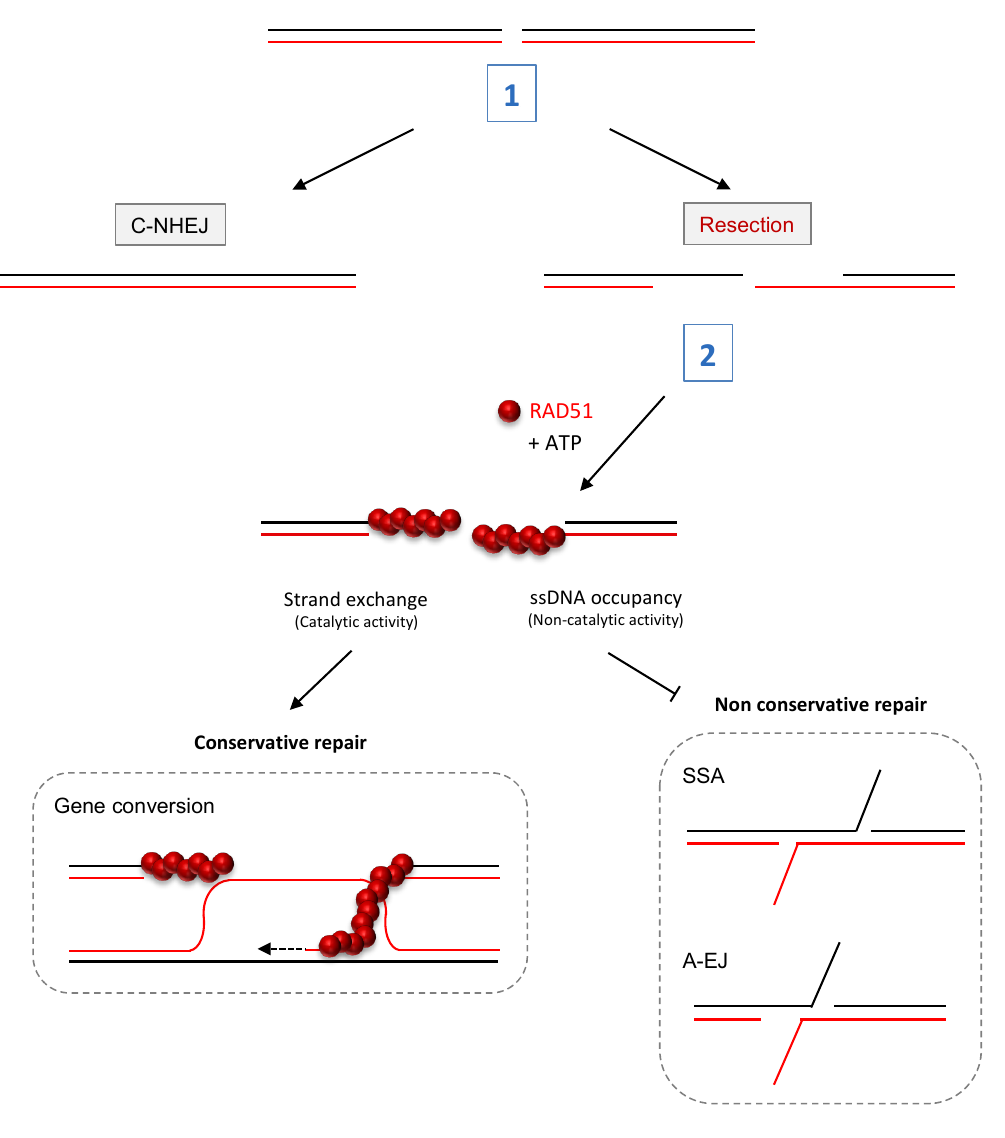
Figure 2. The selection of the DSB repair pathway in two steps. 1. Competition between end-joining of the DSB through the KU70/KU80/ligase 4-dependent NHEJ pathway, called canonical NHEJ (C-NHEJ), versus the resection of the DNA ends generating 3’-ssDNA tails. 2. On resected ssDNA, competition between conservative HR versus alternative nonconservative SSA or A-EJ. SSA and A-EJ occur upon the annealing of the two complementary ssDNA generated by the resection. SSA acts on long homologous sequences, whereas A-EJ acts on microhomologies (few bp). Since both processes anneal complementary sequences that can be distant from the DSB, they both ineluctably lead to the loss of the intervening sequence and are, thus, nonconservative. RAD51 (red dots) not only favors the gene conversion through its catalytic activity but also prevents SSA and A-EJ by occupying the ssDNA and impairing the annealing of the complementary strands [41].